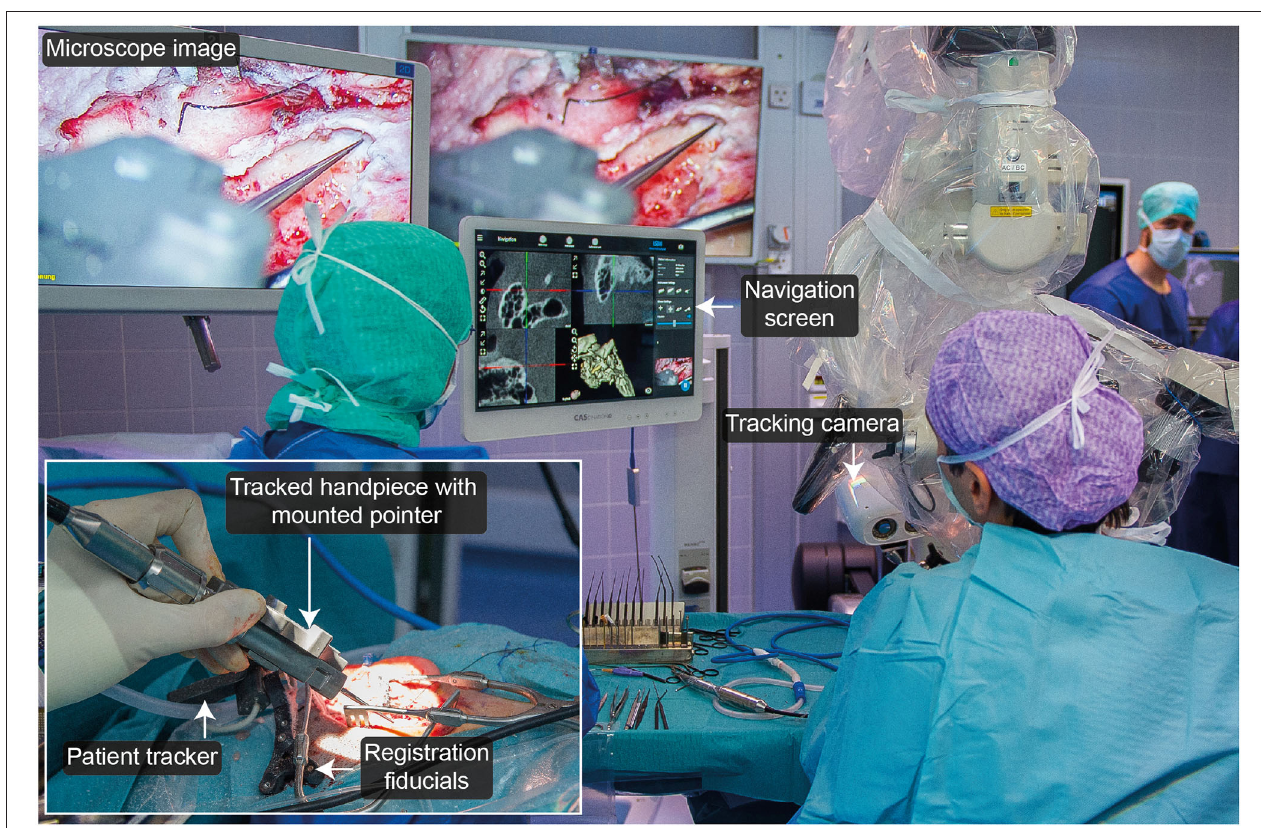
FIGURE 3 | Experimental setup during microscopic removal of a facial nerve schwannoma.